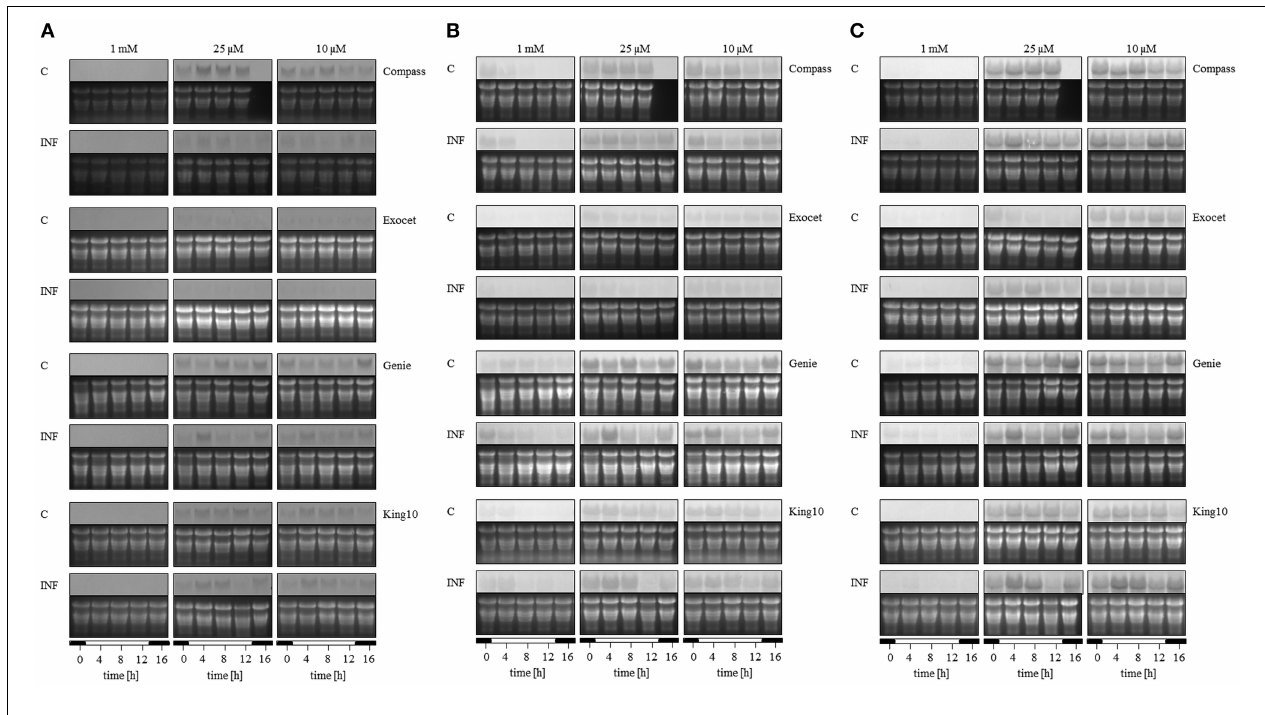
FIGURE 10 | Expression analysis. The expression of (A) SULTR4;2 , (B) APR2 , and (C) APR3 was analyzed by Northern blotting in plants (five leaves fully expanded) treated and collected as described for Figure 5 . Total RNA